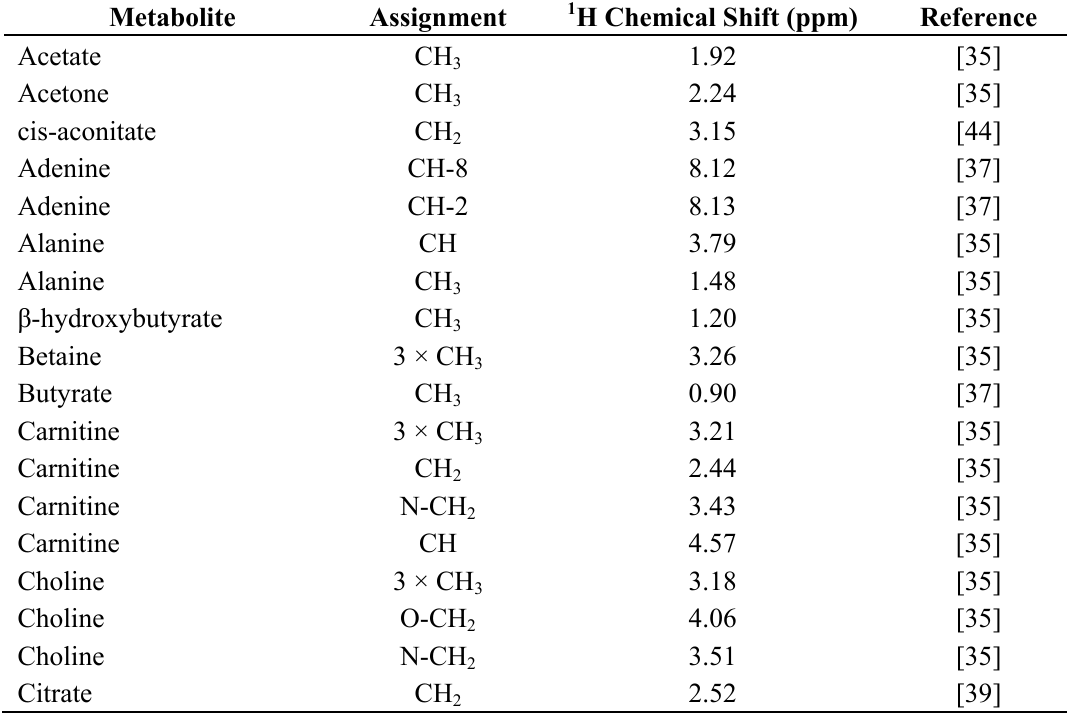
Table 1. List of chemical shift values and proton assignments for milk metabolites identified by 1 H NMR spectroscopy reported in the literature. Reprinted with permission